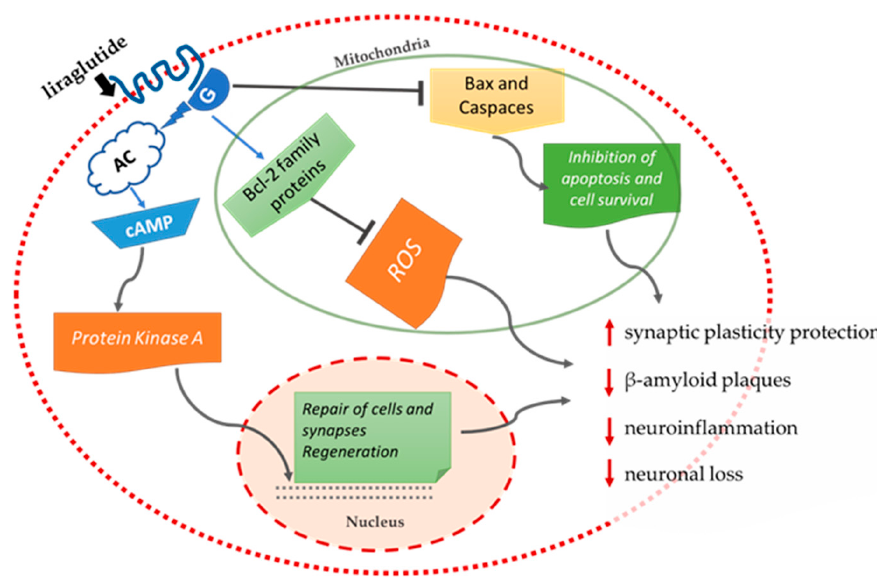
Figure 8. Liraglutide’s preventive and therapeutic properties of AD based on evidence of several studies [70–74]. studies